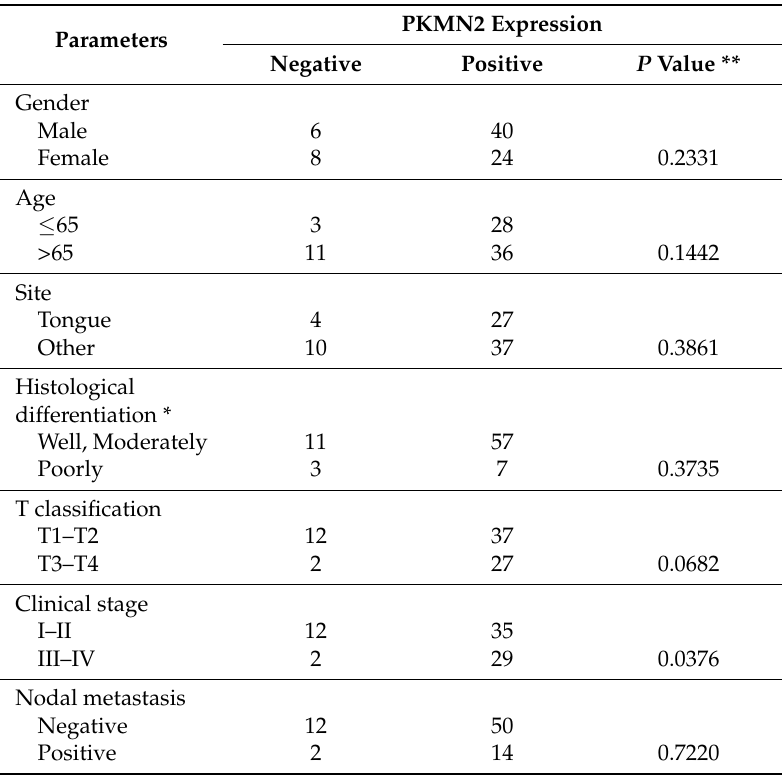
Table 1. Relationship between PKM2 expression and clinicopathological